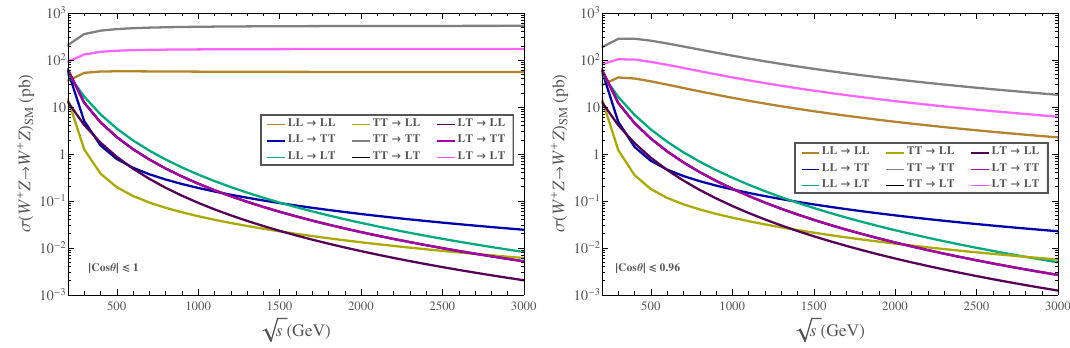
Figure 3 . Predictions of the SM cross section as a function of the center of mass energy, p s , of the process WZ WZ for di(cid:11)erent polarizations of the initial W A Z B ( AB = LL; TT; LT ) and (cid:12)nal ! W C Z D ( CD = LL; TT; LT ) bosons. We display the di(cid:11)erent polarization cross sections integrated in two choices of the center of mass scattering angle, cos (cid:18) 1 (left panel) and cos (cid:18) 0 : 96 (right j j (cid:20) j j (cid:20) panel), corresponding the latter to (cid:17) W;Z < 2. All predictions have been obtained with FormCalc j j and checked with